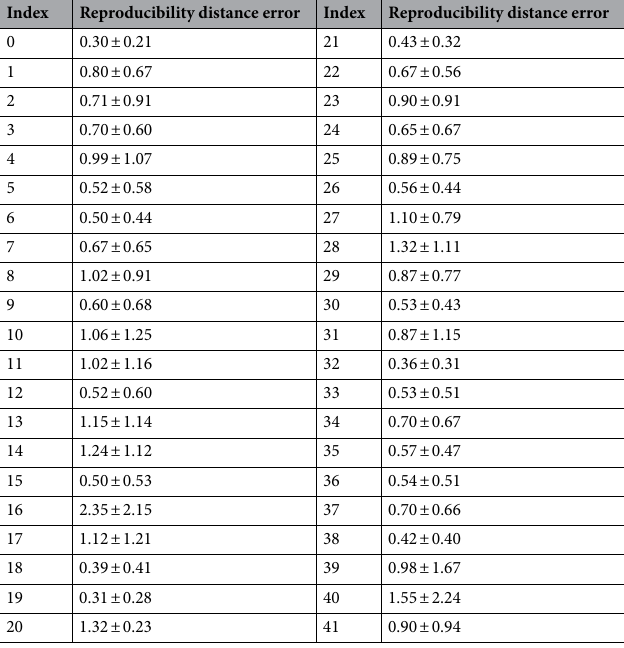
Table 5. Comparisons of distance error (mean ± STD, unit: mm) between first label and second label. (unit: mm). Landmarks measured for the first time in 28 X-rays were called first labels, and landmarks measured for the same patient after 6 months were called second